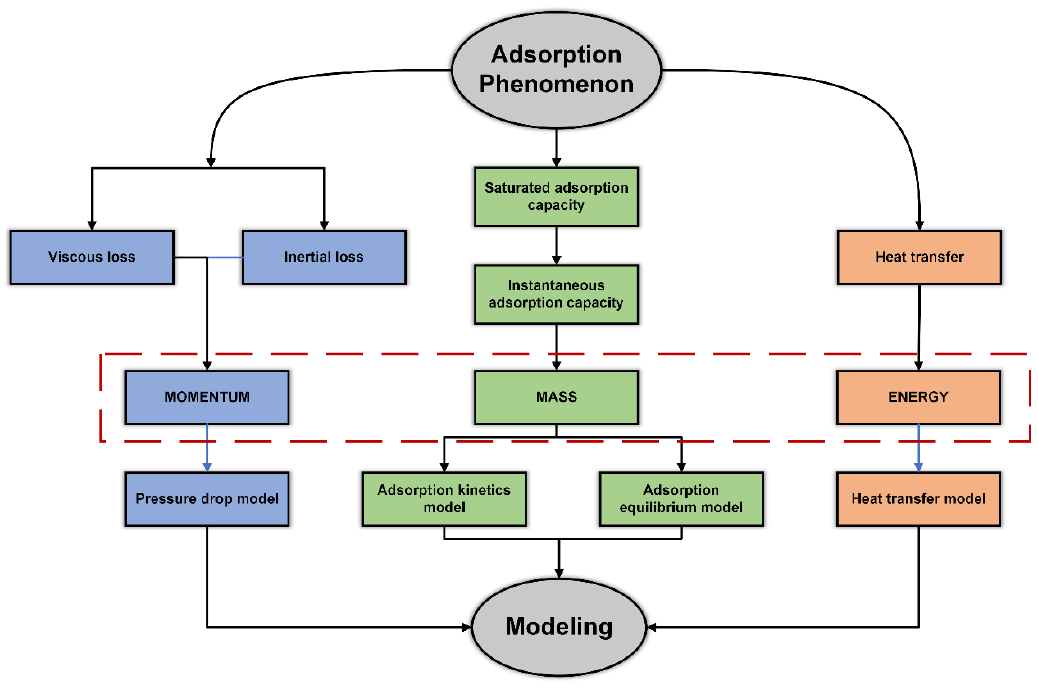
Figure 1. The CCA mathematical modeling pathway map cited from Li et al. [12]. Readapted with permission from Ref. [12]. Copyright 2018 Elsevier.